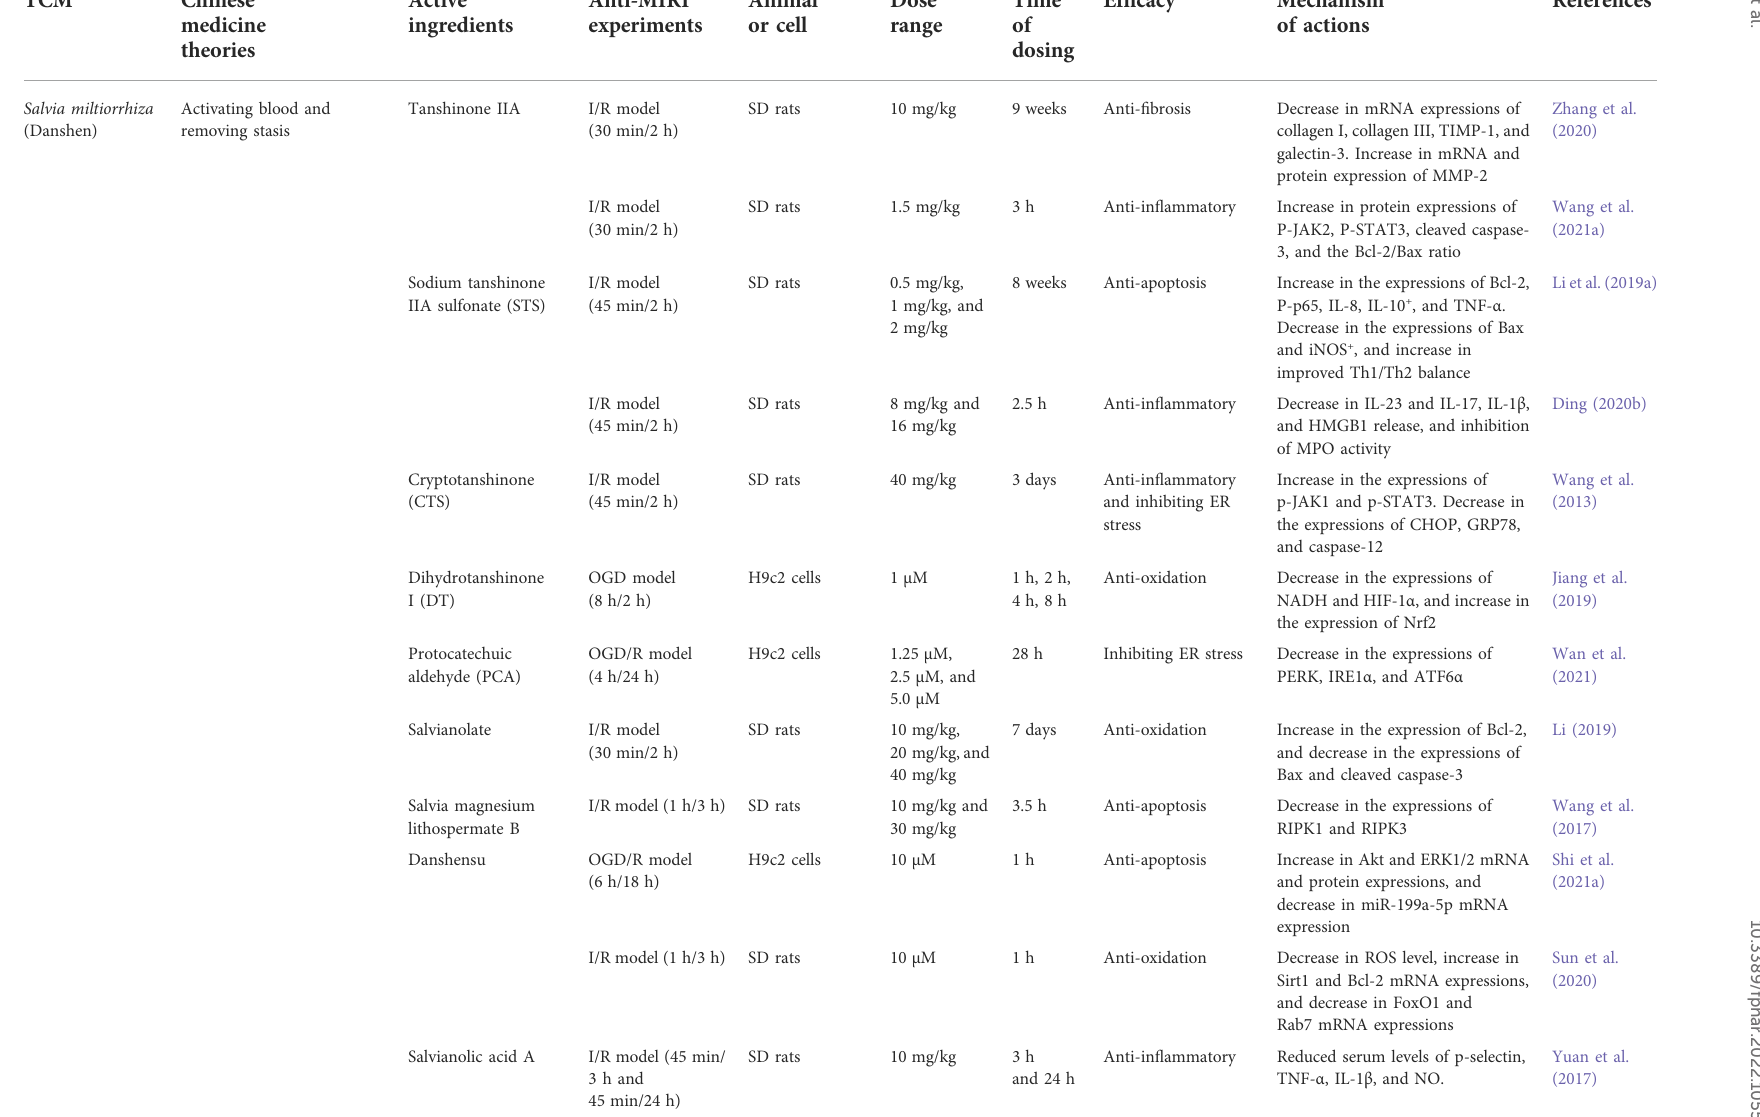
TABLE 1 Medicinal materials and their chemical constituents for the therapy of